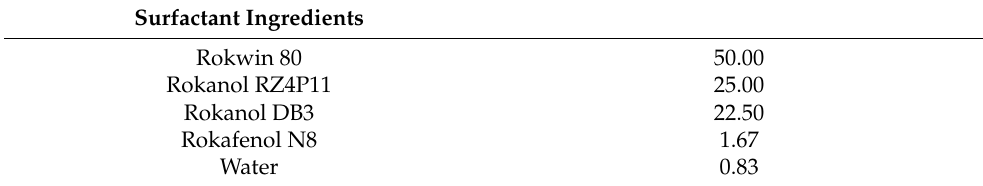
Table 3. Percentage mass fraction of components in the emulsifier.